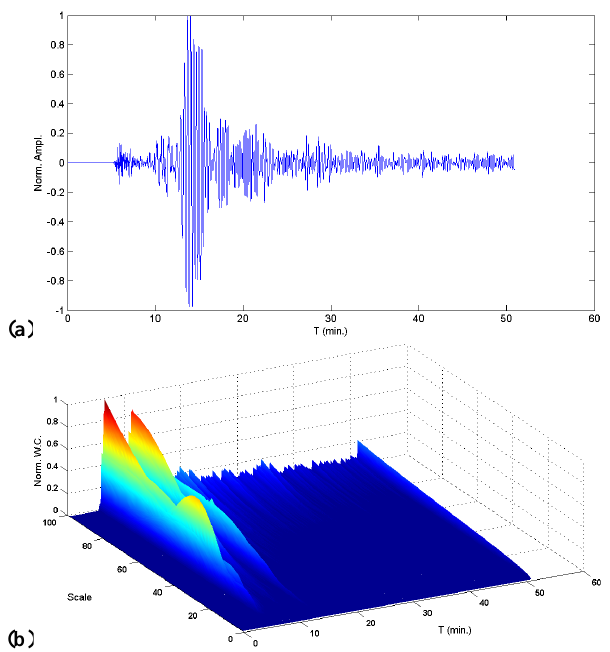
Fig. 3. Wavelet analysis of Nias 28 March 2005. The figure shows (a) seismogram, (b) wavelet spectrum.